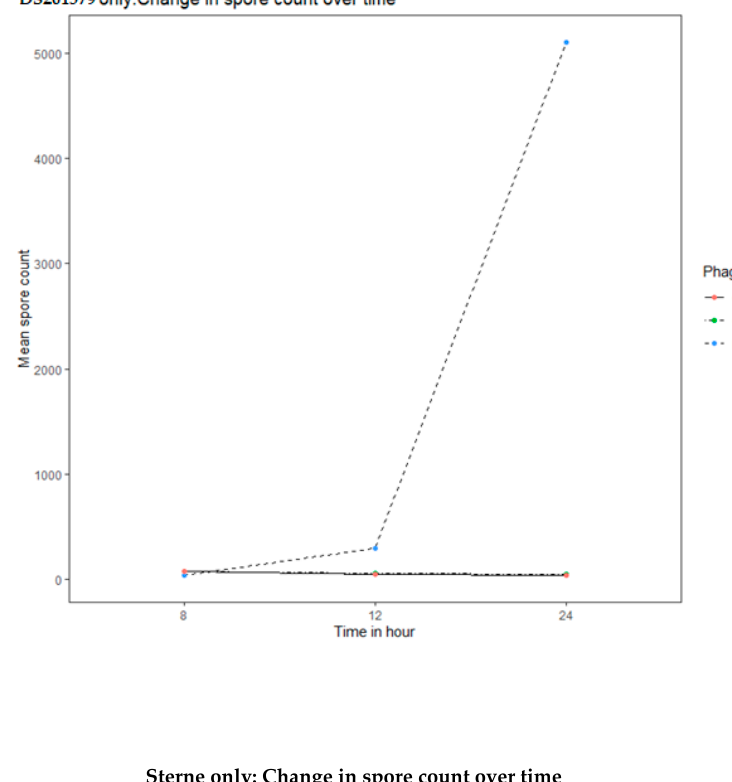
Sterne only: Change in spore count over time